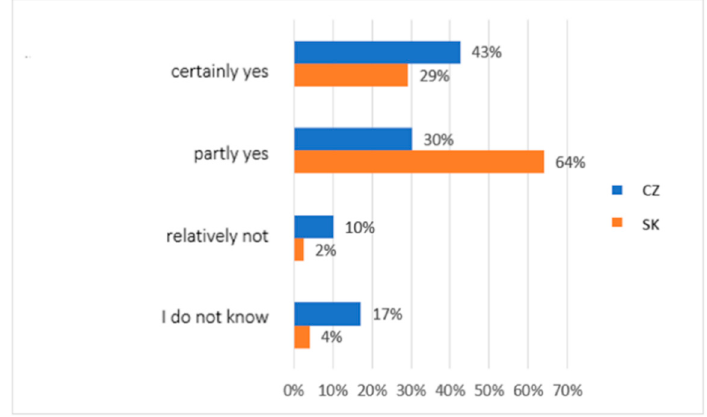
Figure 5. Descriptive statistics of the participants’ subjective perception of the role of religious organisations in the social and pastoral service (comparison of the healthy population of eastern Slovakia and north-western Czech Republic). Legend: CZ—healthy population of north-western Czech Republic, SK—healthy population of eastern Slovakia. Source: own resource.